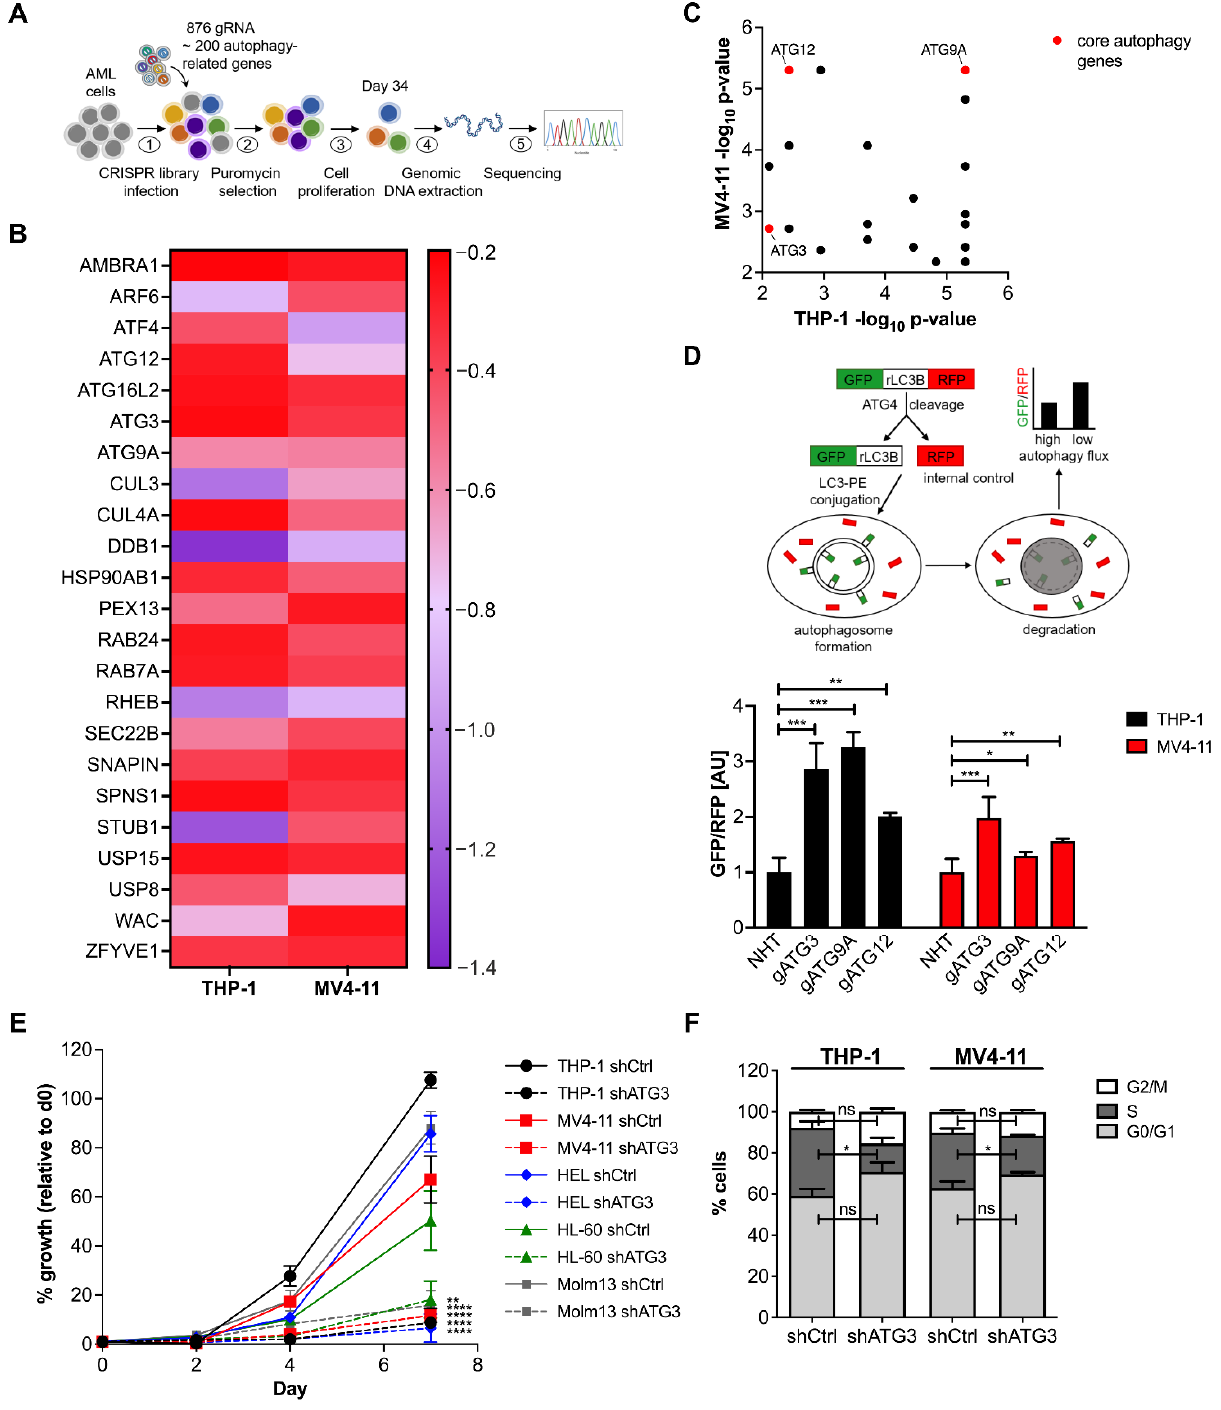
Figure 1. ATG3 drops out in CRISPR/Cas9 screen and loss of ATG3 impairs AML cell proliferation and autophagy. ( A ) Experimental scheme of CRISPR/Cas9 proliferation screen. ( B ) Heat map represents the log 2 fold change (scaled with indicated colors) of the 23 common dropout genes from the CRISPR/Cas9 screen using the autophagy library in THP-1